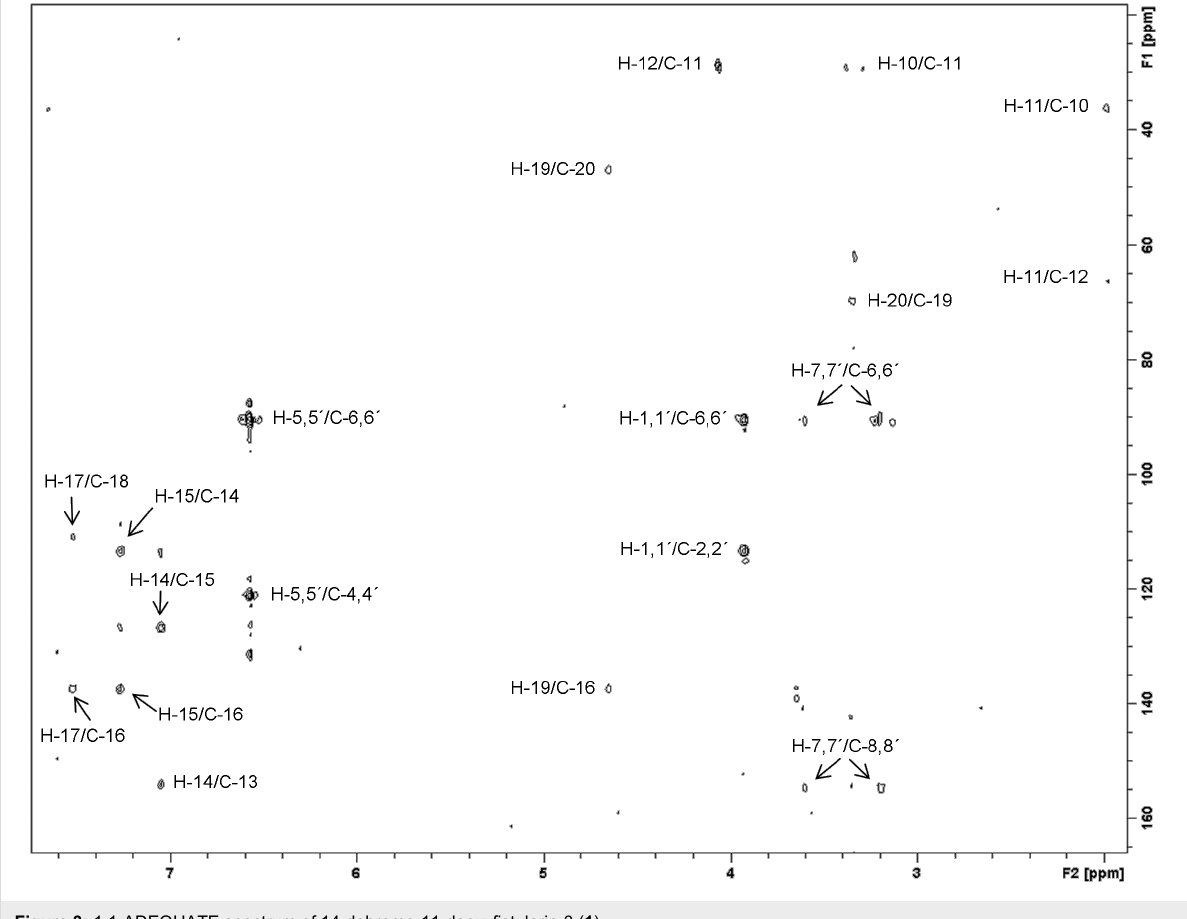
contained an acetamide in the left-side portion instead of a ring system in comparison with 8 and showed great similarity with hexadellin B ( 10 ) isolating from the same organism. Hexadellin B ( 10 ) was originally isolated from the sponge Hexadella